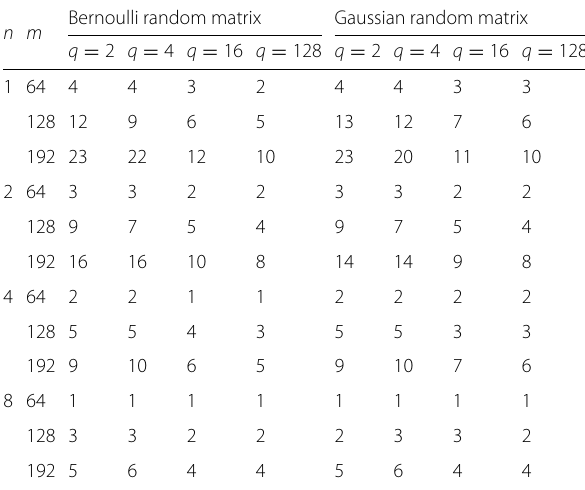
Table 1 Maximal sparsity levels from the CCP algorithm for both Bernoulli and Gaussian random matrices with N = 256 and different combinations of n , m , and q Bernoulli random matrix Gaussian random matrix n m